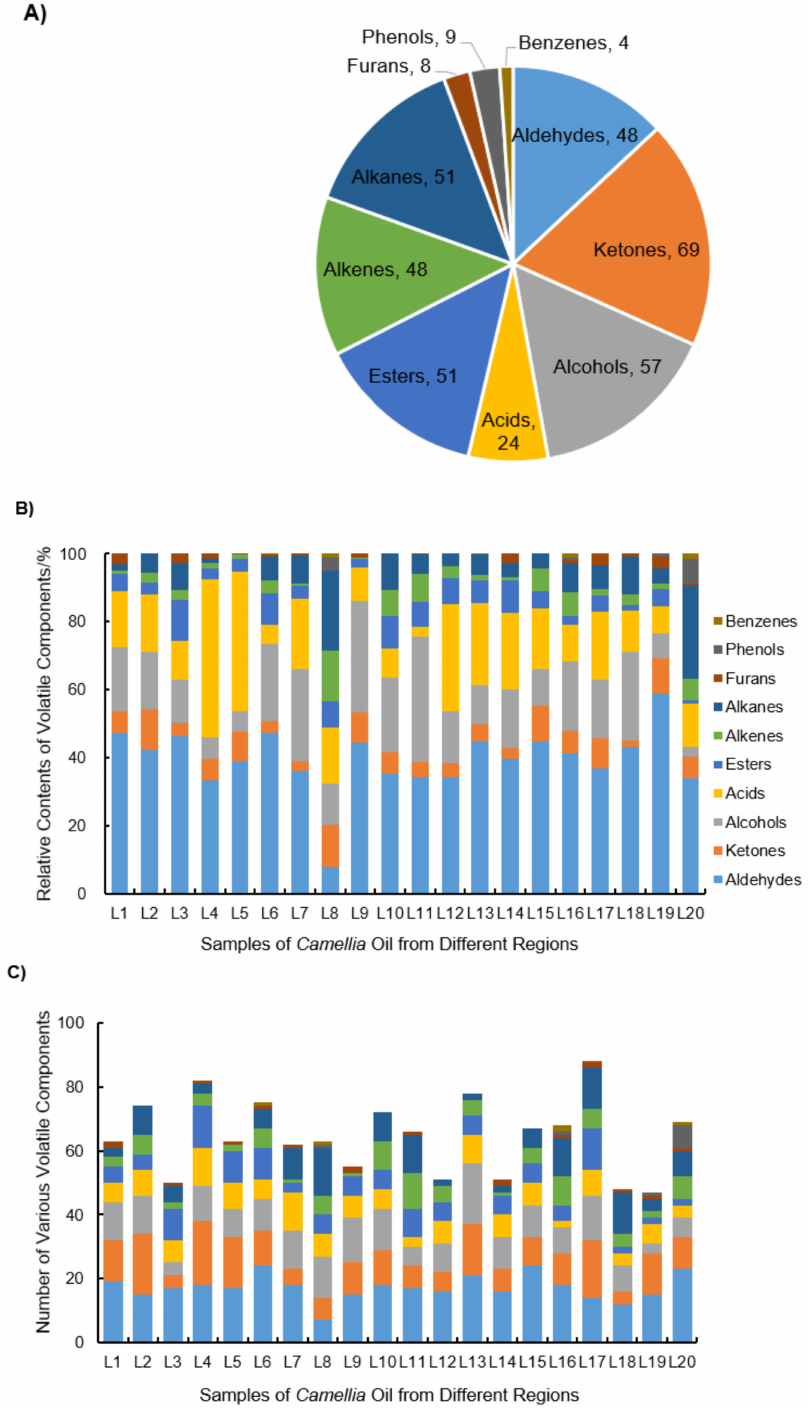
Figure 2. The composition and content of volatile compounds of VCO from 20 geographic regions. ( A ) The number of ketones, alcohols, alkanes, esters, aldehydes, alkenes, acids, phenols, furans, and benzenes in all Camellia oleifera seed oils. ( B ) The relative contents of 10 chemical categories of volatiles in VCO samples from 20 regions. ( C ) The number of various volatile components in VCO samples from 20